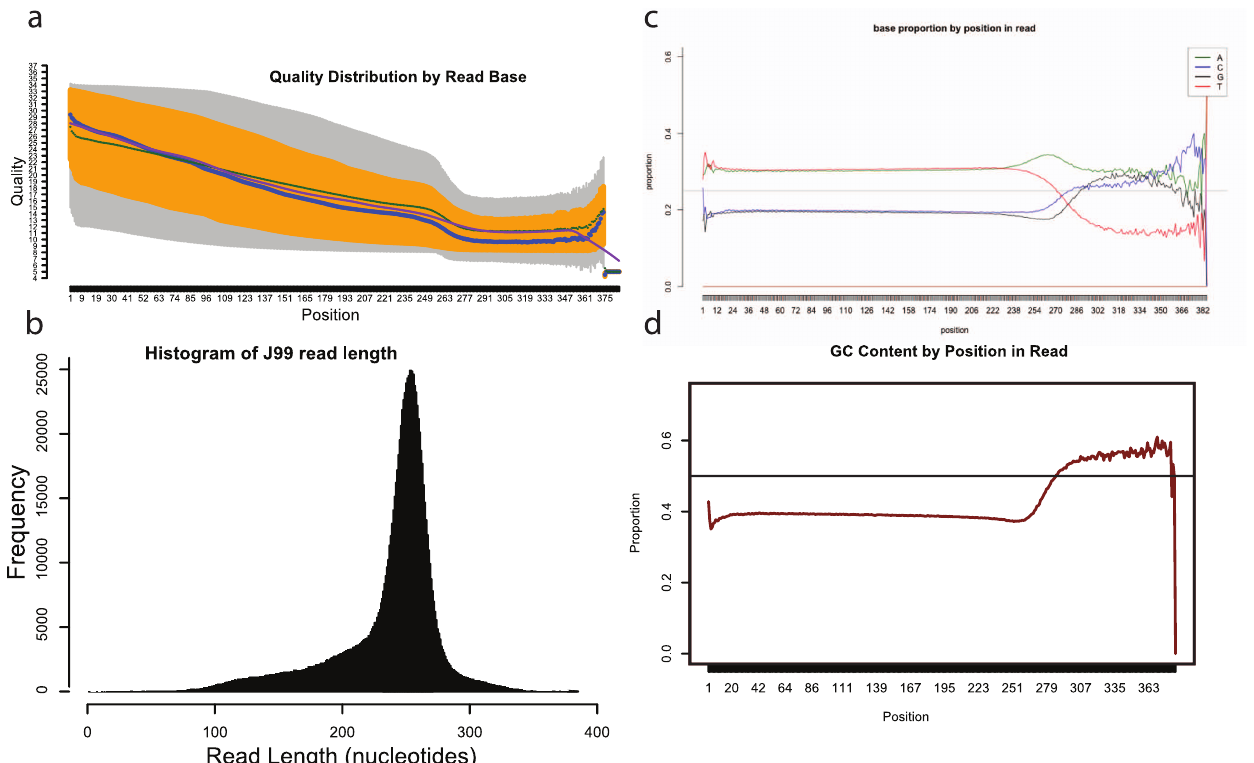
Figure 1. QRQC analysis of J99 raw sequence data derived by Ion Torrent. (a) Plot of the quality distribution by base position. (b) Histogram of the read lengths. (c) Proportions of each base with respect to the position in the read. (d) Mean GC proportion for each position in the reads.